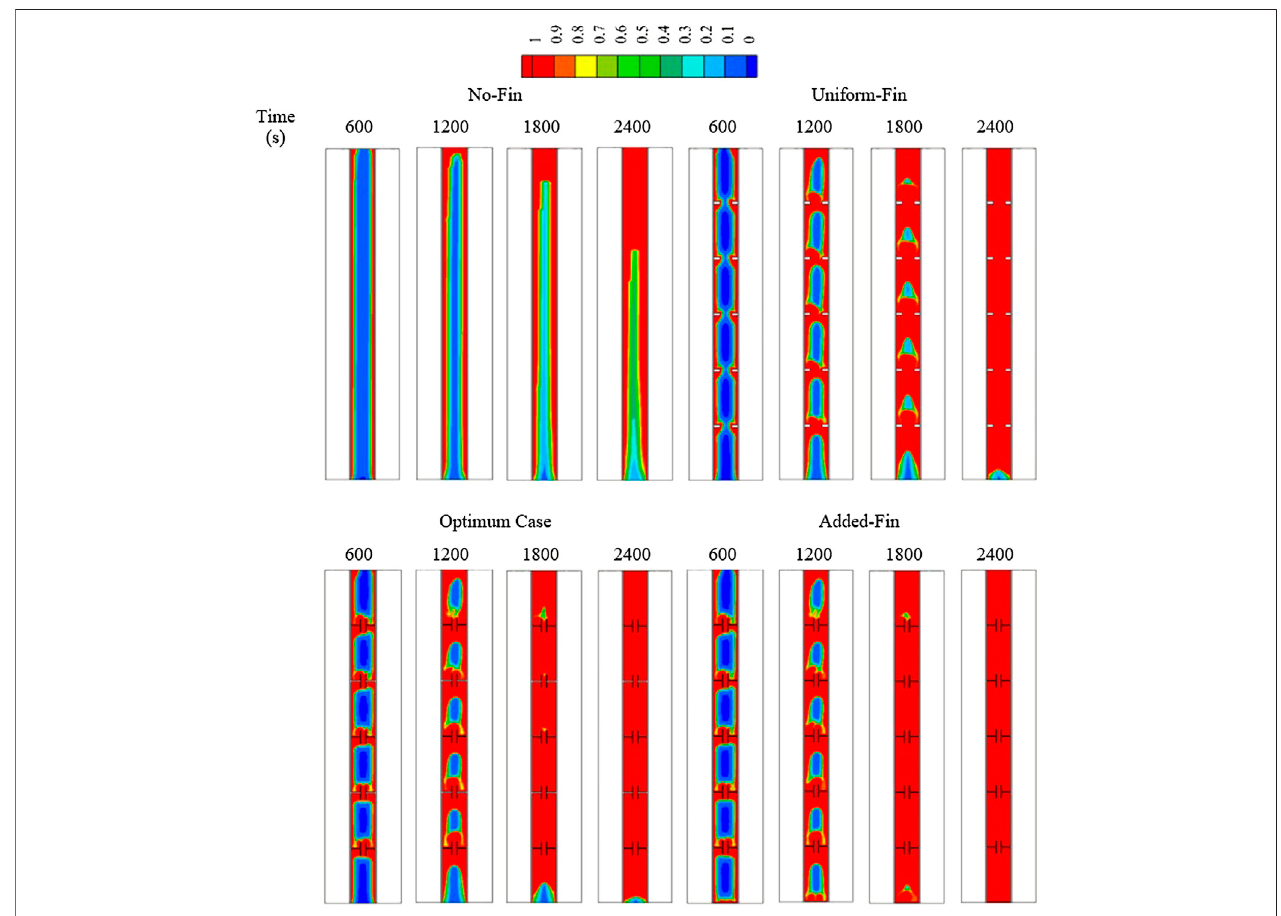
FIGURE 12 | The liquid fraction development for various cases of No-Fin, Uniform-Fin, Optimum, and Added-Fin cases at various times.